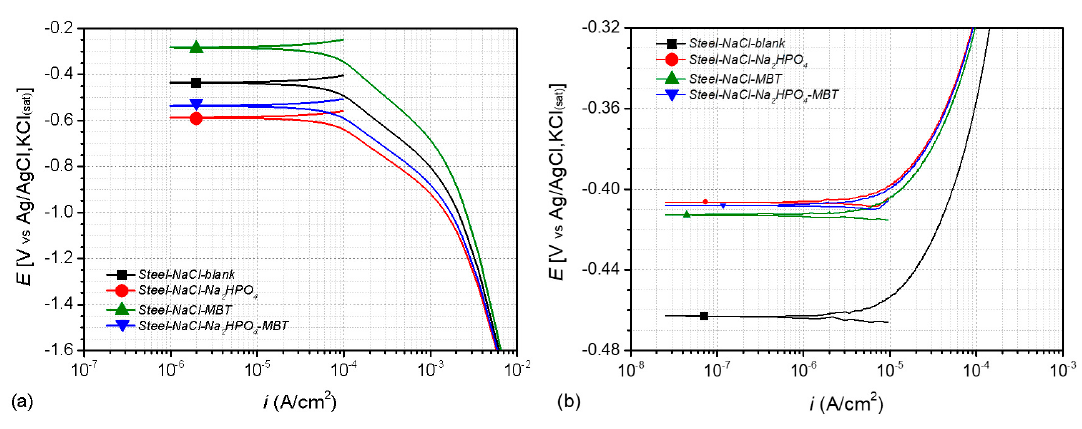
Figure 18. Thepolarizationcurves( a )cathodicand( b )anodic,recordedformildsteelpanelsaftersubmission Figure 18. The polarization curves ( a ) cathodic and ( b ) anodic, recorded for mild steel panels after in 3.5 wt % NaCl for 24 h: ( (cid:4) filled square ) Steel–NaCl–blank , ( (cid:8) filled circle ) Steel–NaCl–Na 2 HPO 4 , ( (cid:78) filled submission in 3.5 wt % NaCl for 24 h: (  filled square ) Steel–NaCl–blank , (  filled circle ) Steel–NaCl– triangleD ) Steel–NaCl–MBT , ( (cid:72) filled triangleU ) Steel–NaCl–Na 2 HPO 4 –MBT . Na 2 HPO 4 , (  filled triangleD ) Steel–NaCl–MBT , ( ▼ filled triangleU ) Steel–NaCl–Na 2 HPO 4 –MBT .